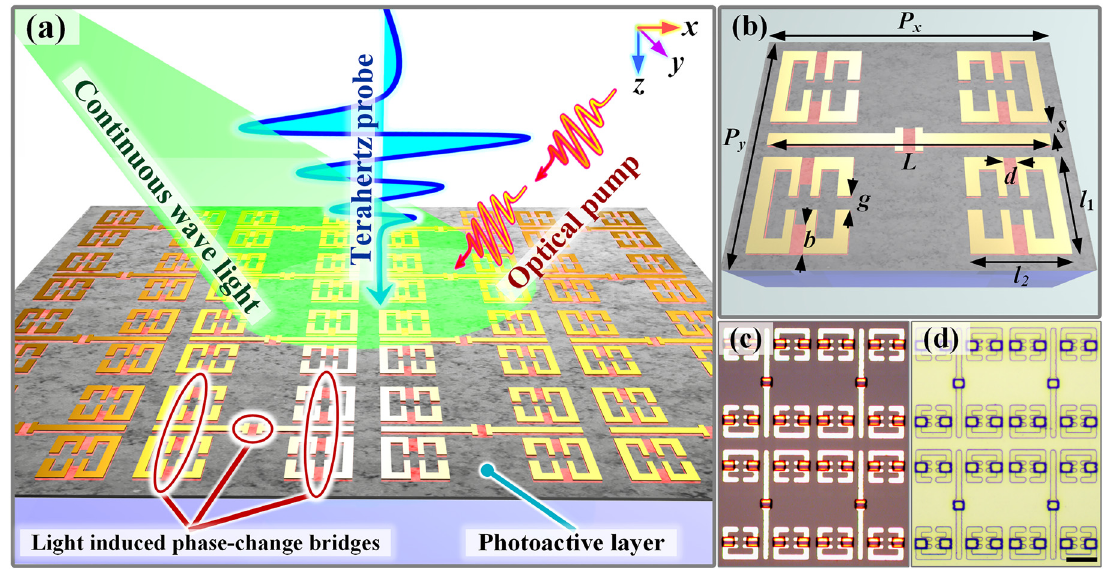
Figure 1: Working principle and characterization of dual-optically controllable metaphotonic devices. (a) A graphical illustration of the concept of the proposed functional metaatoms with ultrafast THz switching at selectable frequencies consisting of resonating metallic antennas hybridized with phase-change bridges and a photoactive layer. The bridges enable the light- inducedmolecularization ofmetaatomstotransittheoperationfrequency,whereasthephotoactivelayerprovidespump-excitedfreecarriers to short-circuit metaatoms with ultrafast switching speed. The incident THz wave polarized along the x direction is inserted into the meta- surface propagating along the k z direction. (b) A 3D artistic illustration of metaatoms within a unit cell, which consists of multiple coupled resonatorswithgeometricalparameters: L =100µm, l 1 =35µm, l 2 =30µm, s =5µm, b =10µm, d =4µm, g =5µm, P x =120µm,and P y =95µm. Here, the thicknesses of the gold metamaterial, VO 2 -bridges, Ge photoactive layer, and sapphire substrate are 200 nm, 100 nm, 200 nm, and 500 µm, respectively. Re fl ective optical microscope images of the hybrid meta-atoms (c) before and (d) after the deposition of a 200-nm-thick Ge fi lm. Scale bar: 30